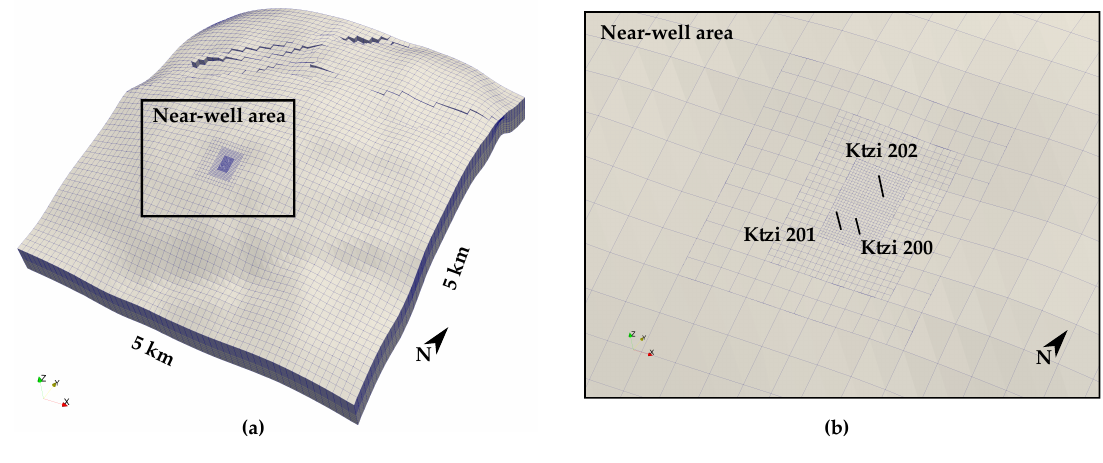
Figure 1. ( a ) Revised reservoir model grid with 102,366 elements and LGRs. ( b ) Close-up view of near-well area, showing well locations and nested LGR structure. Distance between Ktzi 201 and Ktzi 200 is 50 m. Figure copyright [32] (modified), licensed under CC BY-NC-ND